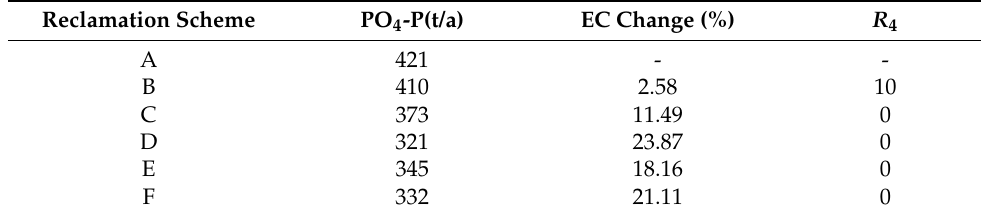
Table 8. Feasibility evaluation in PO 4 -P environmental